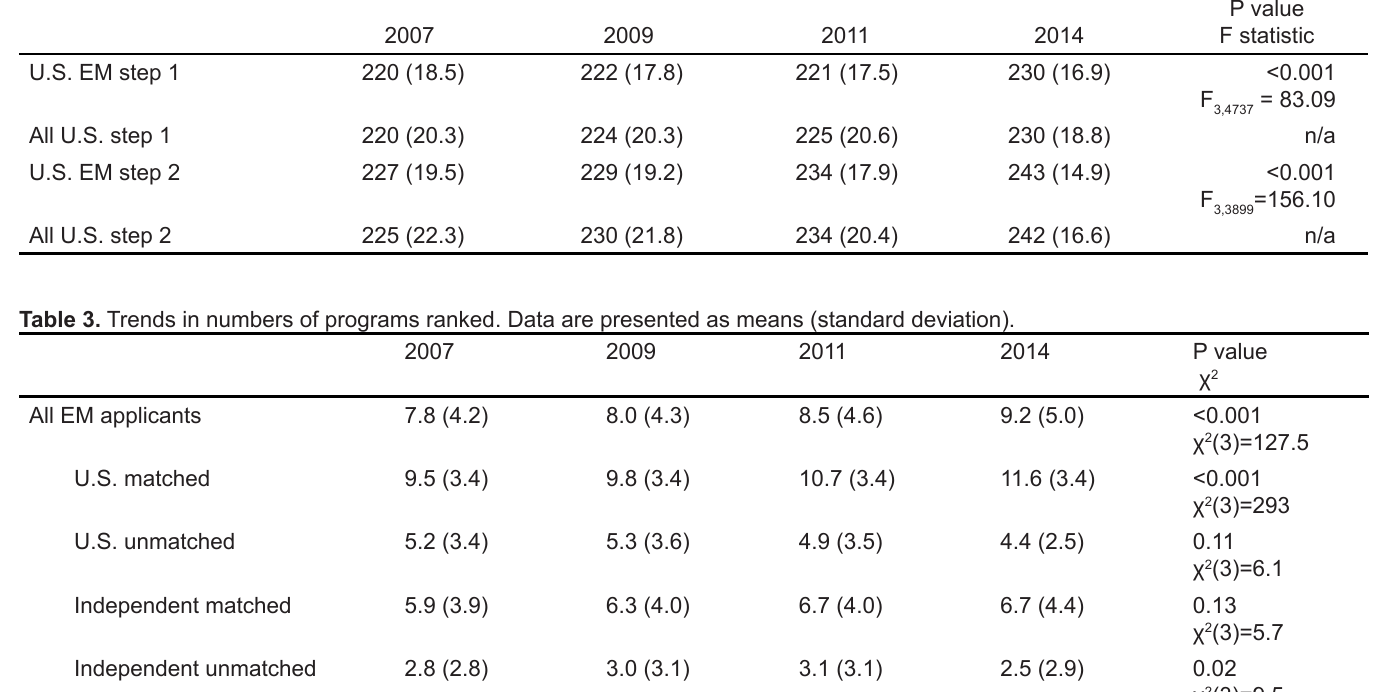
Independent , international applicant.